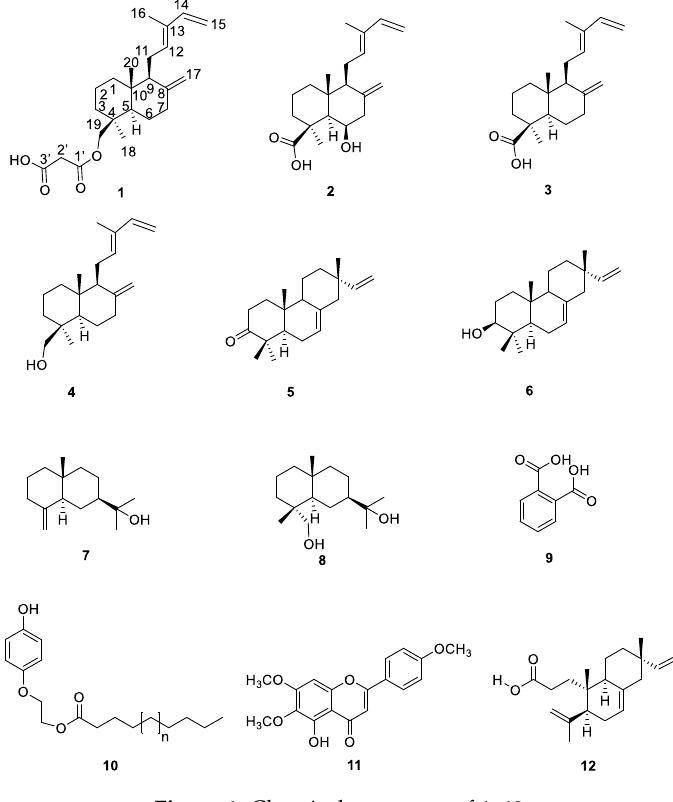
Figure 1. Chemical structures of 1 – 12 .